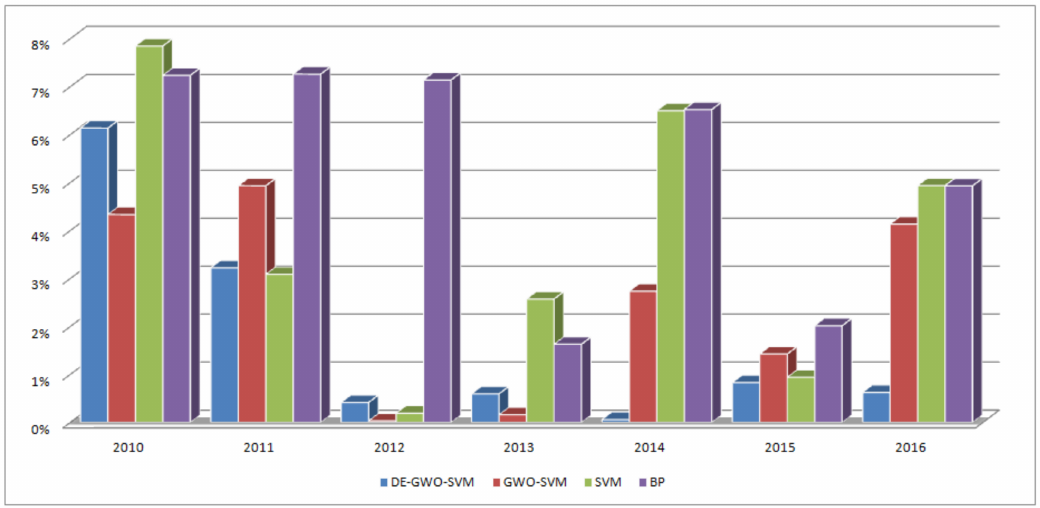
Figure 6. The relative errors.